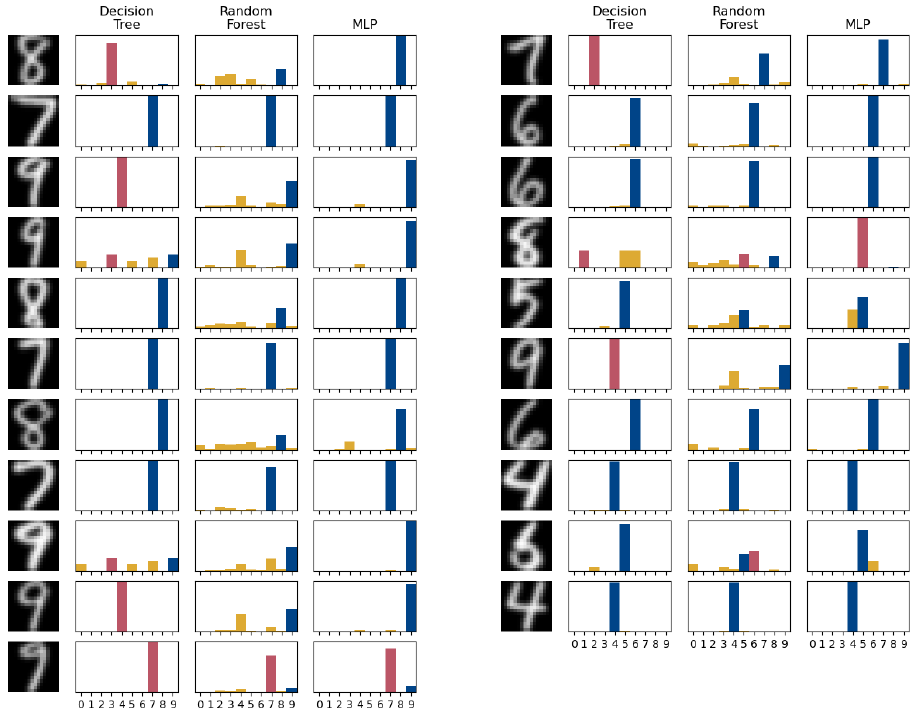
Figure 17. Exemplars over-represented in Q b , with class probabilities under three algorithms trained on X a . The true class is shown in blue ; where the highest probability class differs from the true class, the highest probability class is shown in red